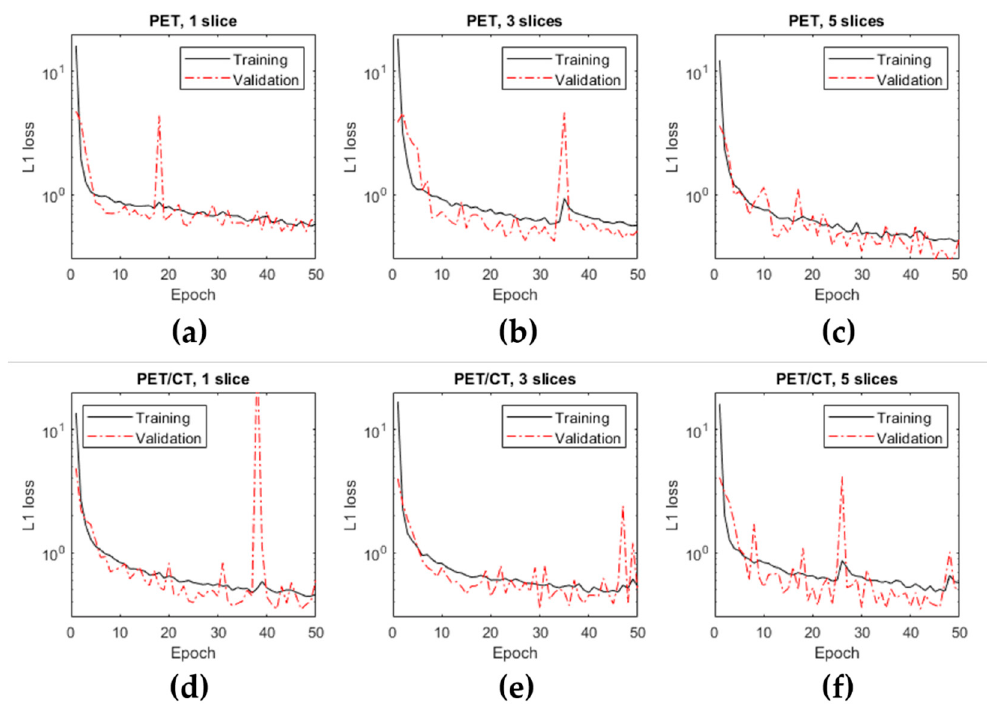
Figure 5. Evolution of the loss function over the epochs during the training using the training and the validation datasets for the different cases evaluated.